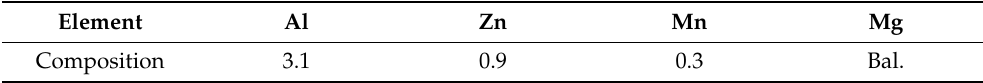
Table 1. Chemical composition of the homogenized AZ31 Mg alloy (wt.%). Element